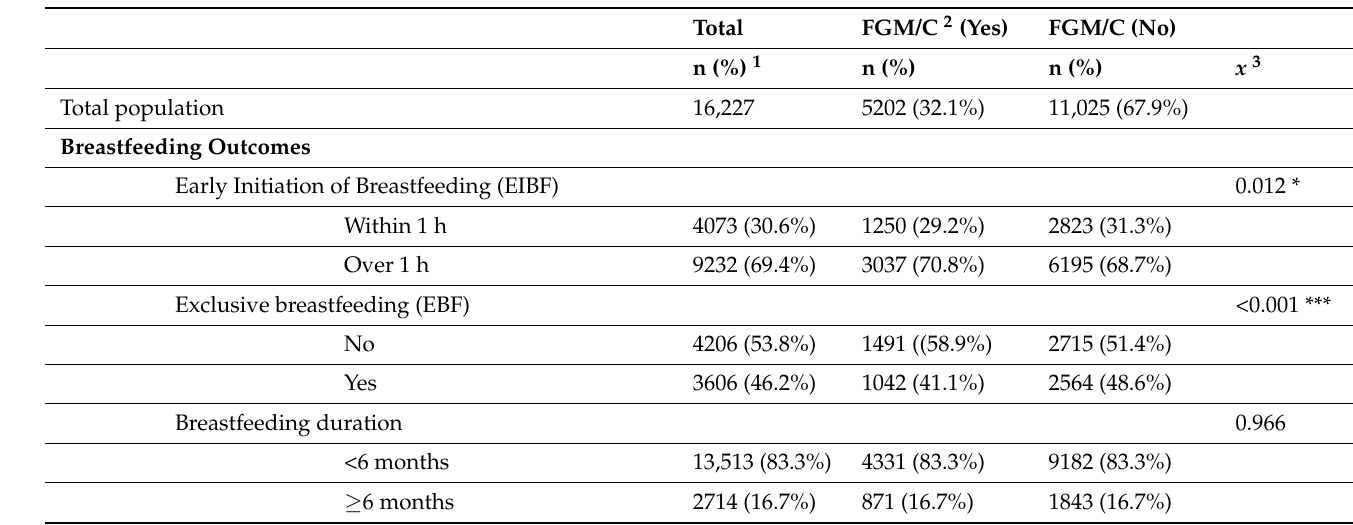
Table 1. Characteristics of Nigerian women based on exposure to Female Genital Mutilation